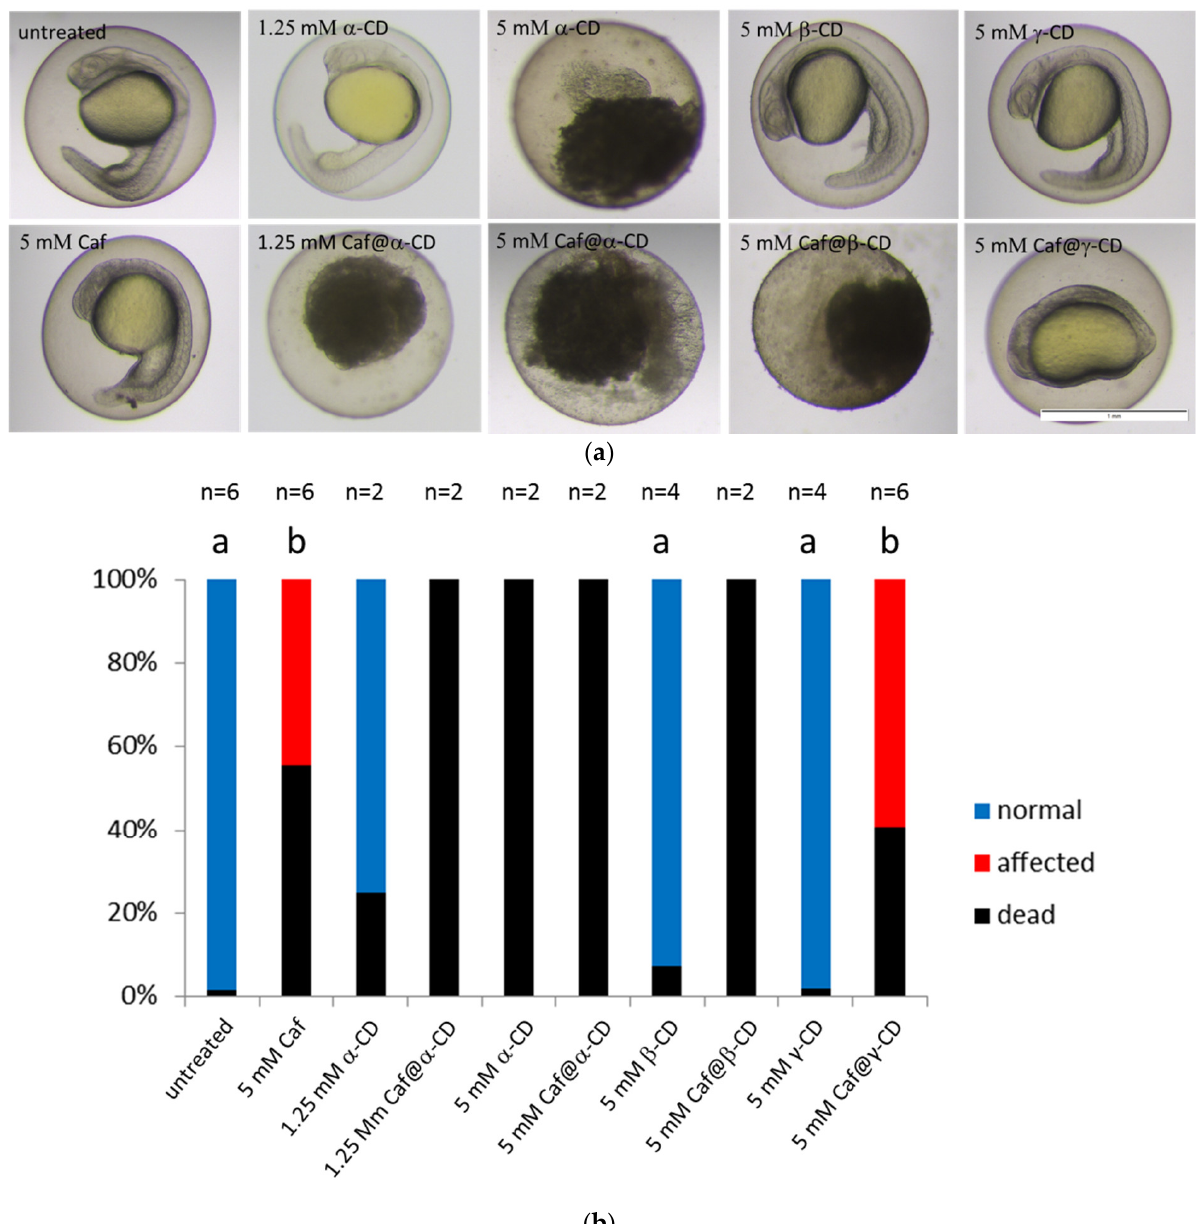
Figure 6. The effect of Caf@CDs on early development of the zebrafish embryo. ( a ) Images of zebrafish embryos after exposure to caffeine (Caf), CDs or Caf@CDs from 4 till 24 hpf. Embryos exposed to Caf@γ-CD show underdeveloped eyes, ears and severely impaired convergent extension. Less severe morphological abnormalities were also present in embryos exposed to 5 mM Caf. Exposure to 5 mM α-CD, 1.25 mM Caf@α-CD, or 5 mM Caf@β-CD was lethal to the embryos. Examples of live embryos at a most advanced developmental stage are shown. Scale bar, 1 mm. ( b ) Changes in the proportion between the dead, morphologically abnormal (affected), and unaffected (normal) embryos. The percentage of embryos which died upon treatment with Caf or Caf@CDs was significantly higher than that of untreated control. Also, pure α-CD was more toxic than the other two CDs, whereas β-CD and γ-CD had no effect on both the fish survival and their morphology. In order to reduce the number of animals, in the case of treatments which caused 100% rapid mortality, the experiments were repeated twice. Bars present mean values, n is the number of repetitions, each on 24 embryos. Mann-Whitney U test was performed on samples with ≥ 3 biological replicas. Statistically significant differences (P < 0.01) were marked with different letters.